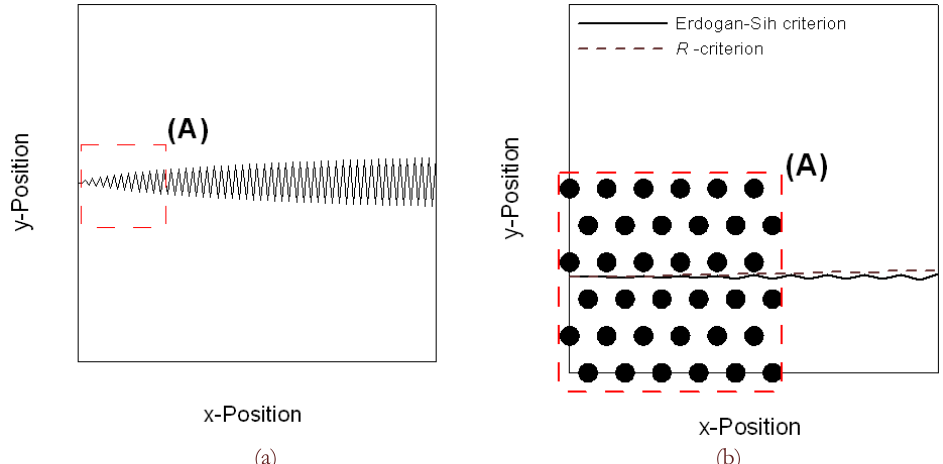
Figure 9: (a) Path of an initially straight crack developing at half distance between two lines of inclusions in an infinite plane under  . (b) Detail of the crack path at the microscale where the distribution of inclusions is remote uniform tensile stress y 0